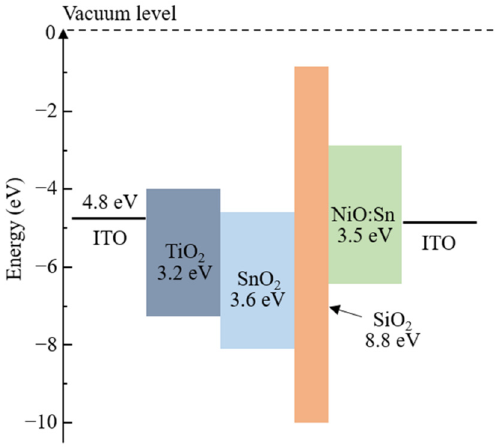
Figure 1. Layer structure and energy band diagram of all-solid-state EC